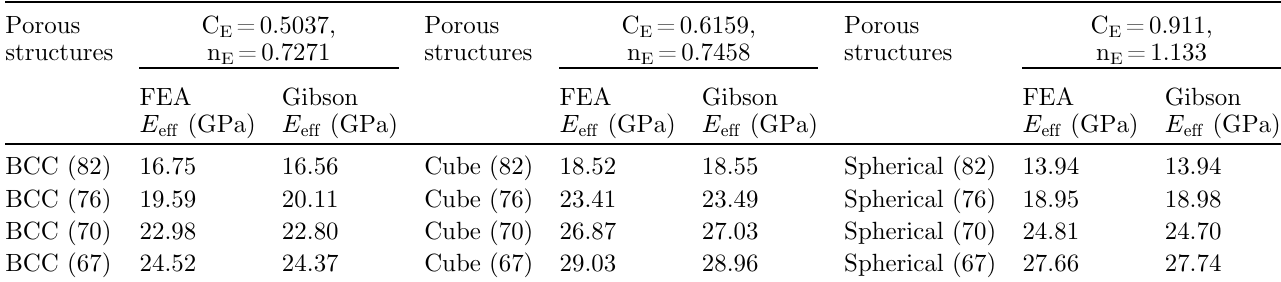
Table 2. FEA and Gibson-Ashby effective elastic moduli of all porous structures with different porosities. Porous structures